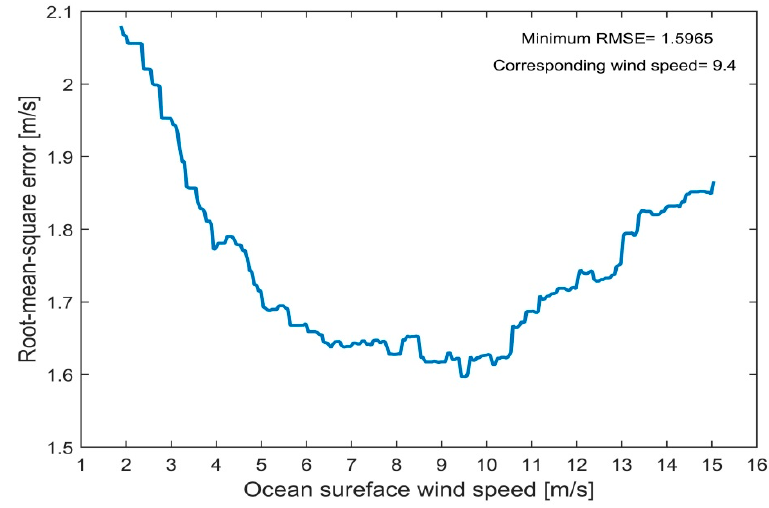
Figure 9. Variation of RMSE with different wind speeds using our hybrid OSWS retrieval model.